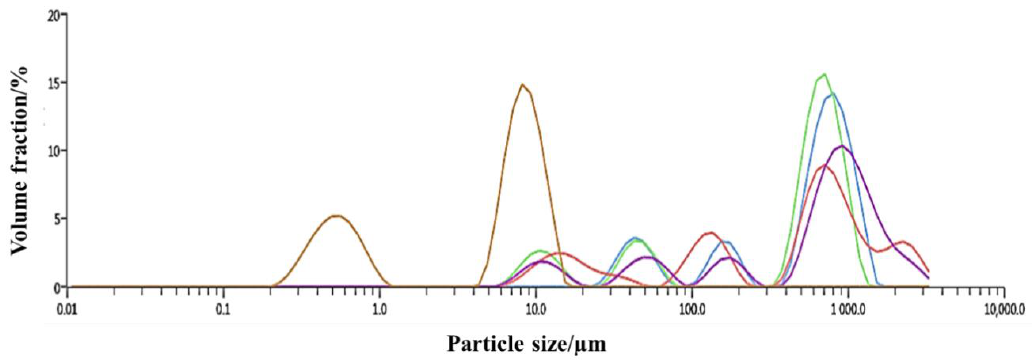
Figure 5. Trend chart of data curve.